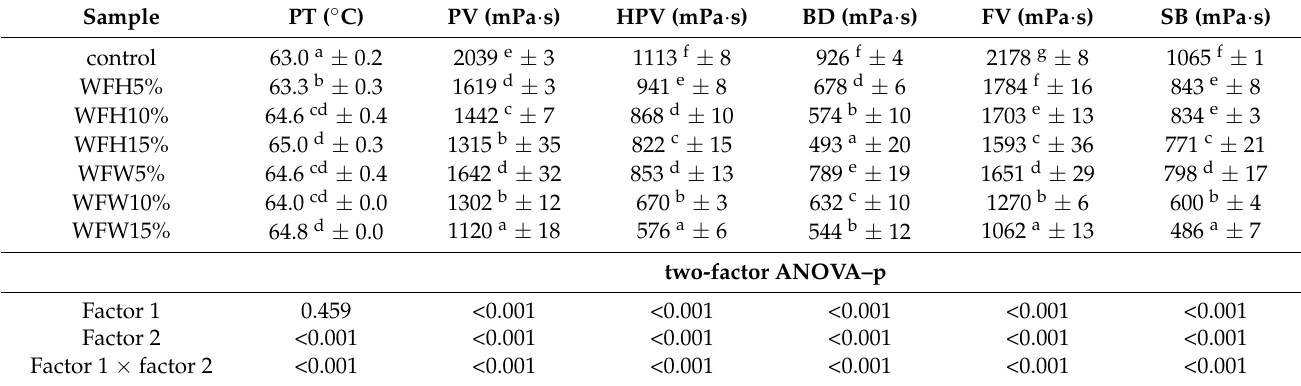
Table 2. Pasting characteristics of systems wheat flour with